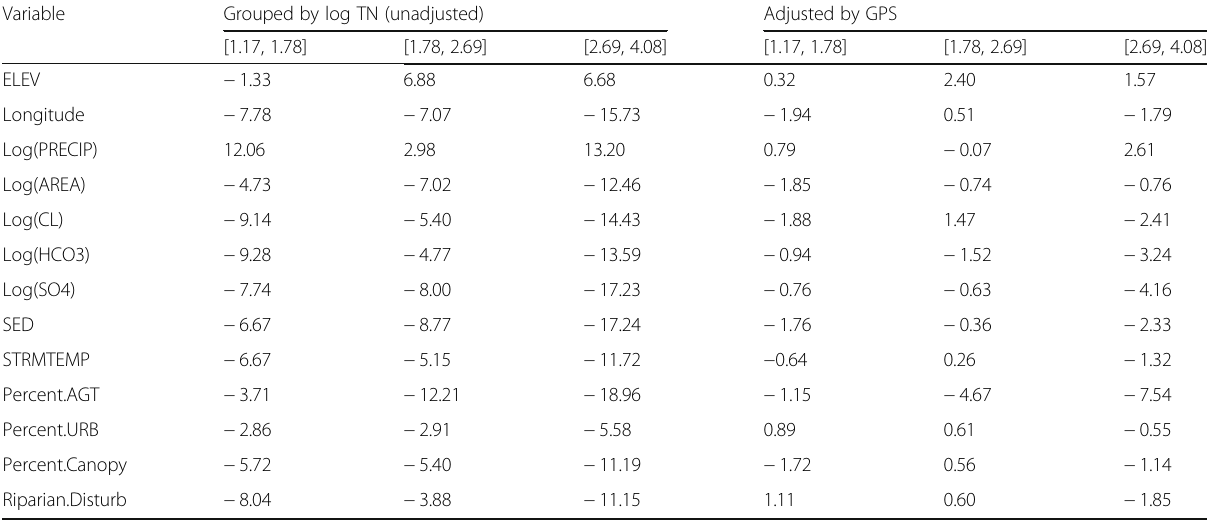
The “ Grouped by log TN ” columns compare confounding factors in the three subsets divided by three continuous intervals of log TN (in brackets), each with about 1/3 of the total samples. The “ Adjusted by GPS ” columns compare the confounding factors based on GPS in two steps: (1) data were divided based on GPS into six groups and (2) data within each GPS group were further divided into three groups based on the same log TN brackets, and mean differences were calculated. The sample size-weighted averages of these mean differences are shown